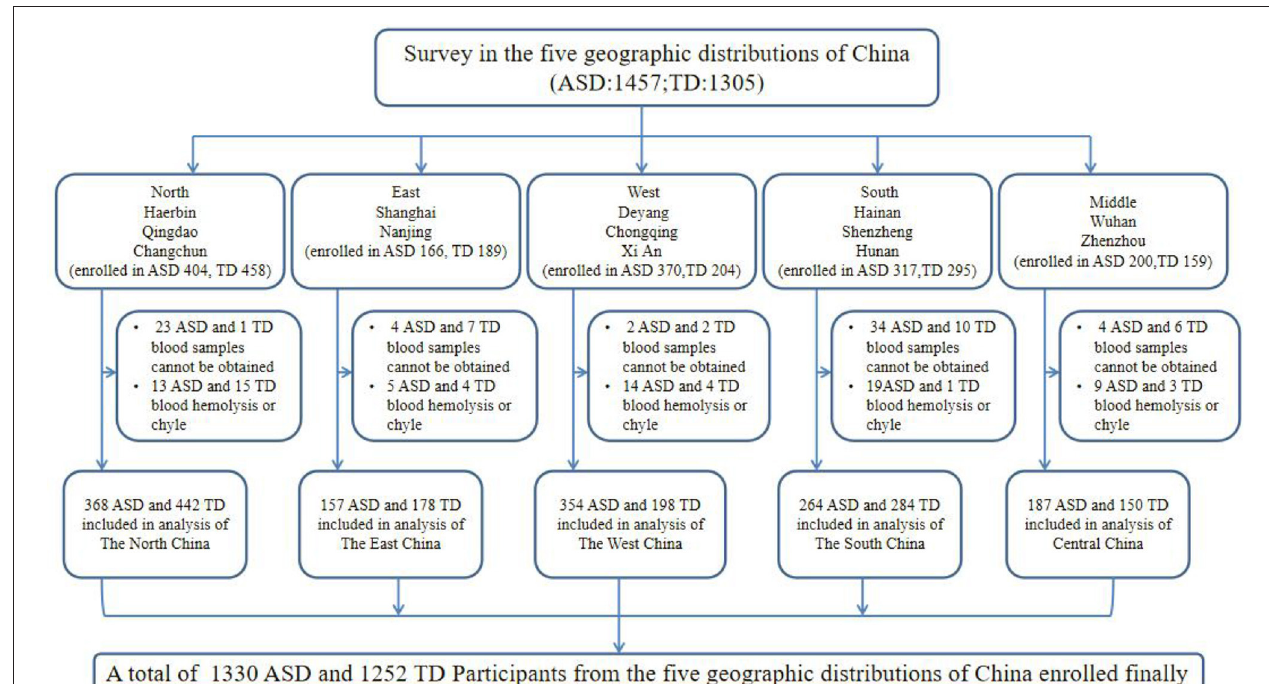
FIGURE 1 | Flow diagram illustrating the survey participants: a multi-center study in China. ASD, autism spectrum disorder; TD, typically developing.